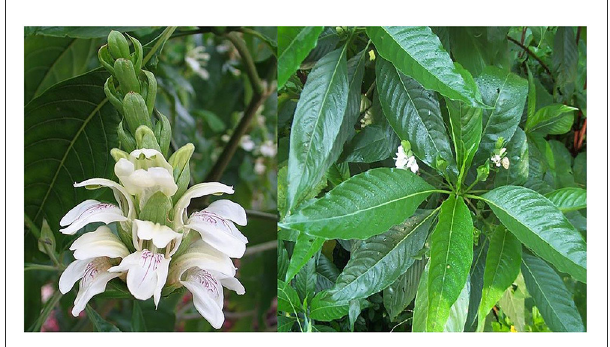
FIGURE1 Flower and leaves of Adhatodavasica .